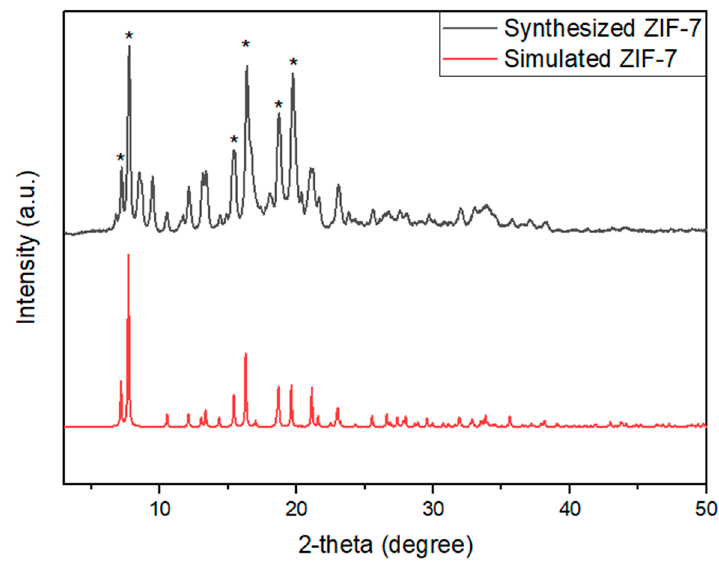
Figure 3. XRD patterns of synthesized and simulated ZIF ‐ 7. Asterisk (*) denotes main peaks. Figure 4 are FE ‐ SEM images of the synthesized ZIF ‐ 7. The synthesized ZIF ‐ 7 was